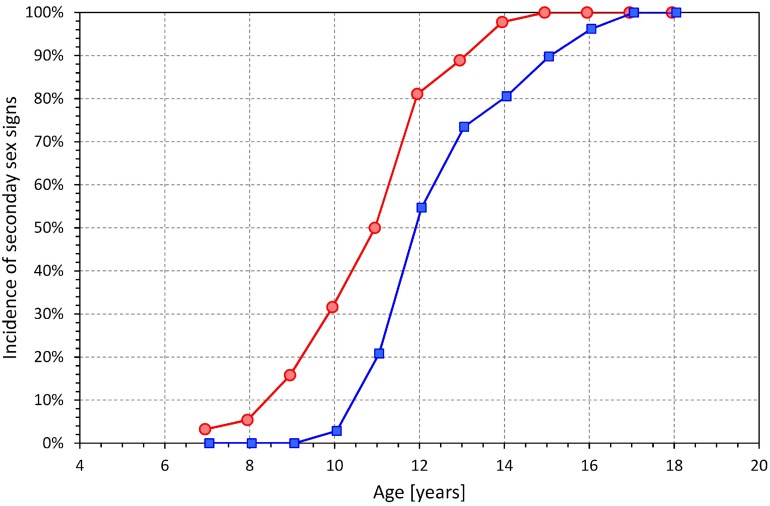
Incidence of secondary sex signs in age bands <8 years, 7–9 years, 8–10 years, etc. up to 16–18 years, and >17 years (each shown approximately at the middle age of the band). Compare with the development of QTcI changes shown in the middle panel of Figure 6.